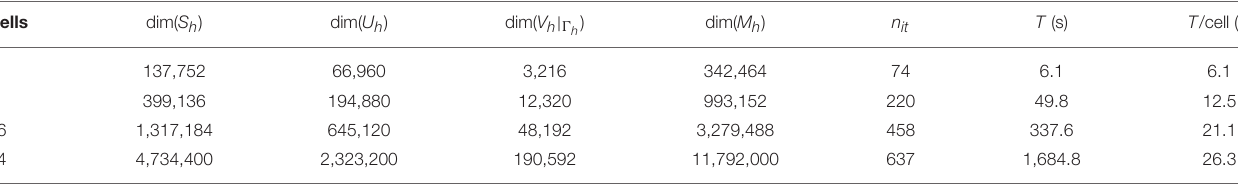
TABLE 9 | CPU times for the H(div) finite element method for a passive membrane model. Cells